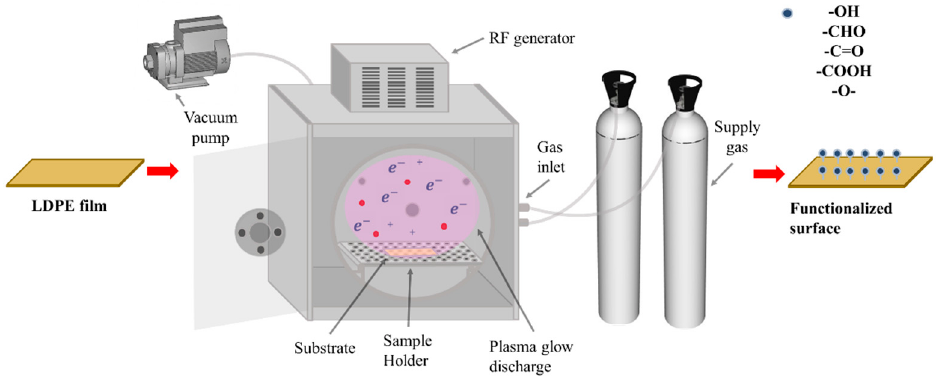
Figure 1. Schematic diagram of the surface modification process using radio-frequency (RF) plasma setup.